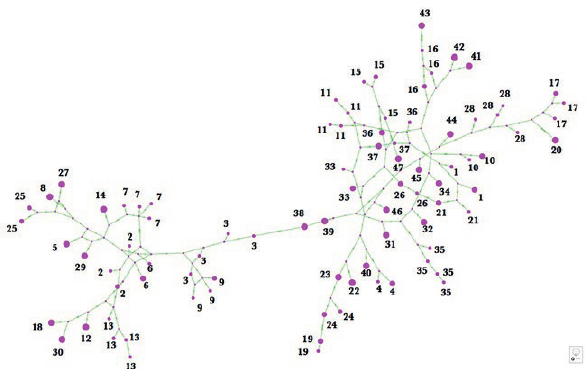
Figure 1. TCS network of Punica genotypes based on SCoT data showing that these markers can differentiate the replicates of tunica genotypes from each